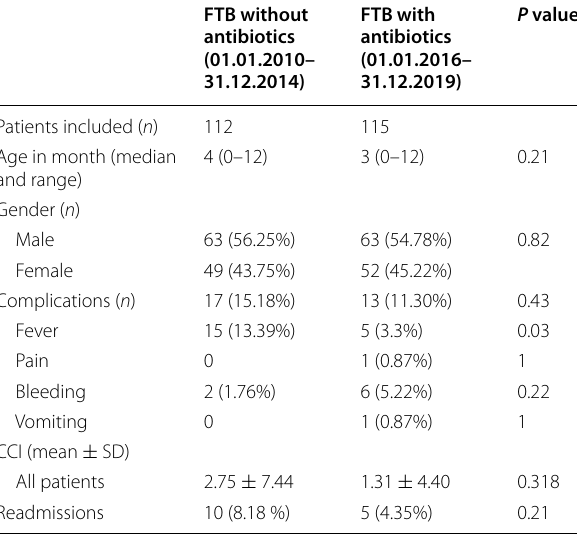
Table 1 Descriptive data and incidence of complications within 30 days after full-thickness rectal biopsies